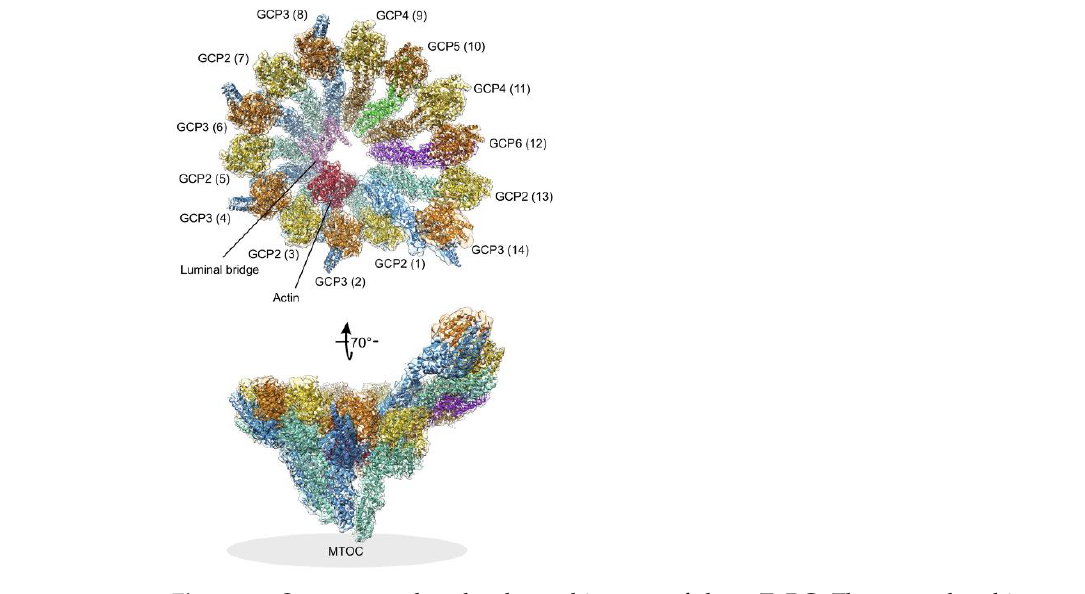
Figure 2. Structure and molecular architecture of the γ -TuRC. The general architecture of the vertebrate left-handed γ -TuRC spiral as determined by cryo-EM single-particle analysis. γ -Tubulins (yellow, orange), GCP2 (aquamarine), GCP3 (blue), GCP4 (brown), GCP5 (green), GCP6 (purple), actin (red), and the luminal bridge (pink) are shown. The spoke numbers are given in brackets. In the tilted view, the approximate location of the MTOC is indicated. (Reprinted by permission from Elsevier: (Curr. Opin. Struct. Biol.; Zupa et al. [60]), copyright (2021).